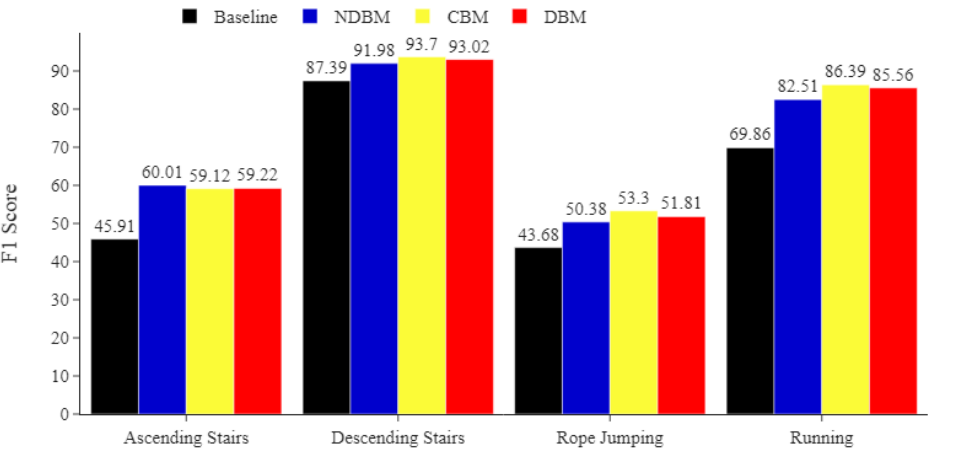
Figure 7. PAMAP2 minority classes. Comparing the impact of DBM, NDBM, and CBM on activity recognition performance, using MLP for the most underrepresented activities (ascending stairs, descending stairs, rope jumping, and running). The reported means of F 1 scores are obtained from 30 repetitions. The F 1 score is in %.